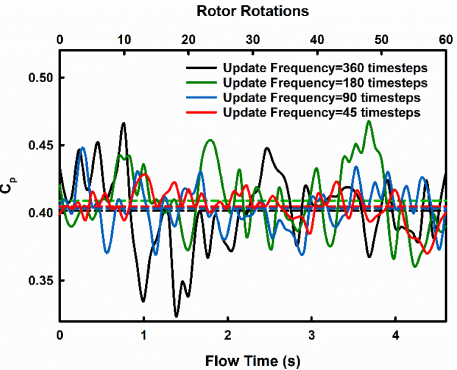
Figure 9. Variation of C p for various randomisation update frequencies. Corresponding mean C p is represented through dashed